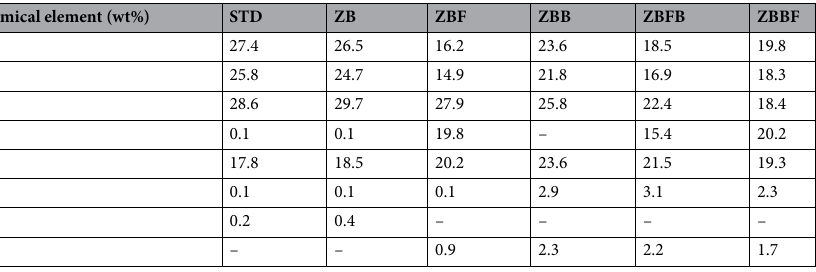
Table 2. The chemical elements of zeolite A standard (STD), zeolite A sugarcane bagasse fly ash powder (ZB), zeolite A sugarcane bagasse fly ash powder mixed iron(III) oxide-hydroxide (ZBF), zeolite A sugarcane bagasse fly ash beads (ZBB), zeolite A sugarcane bagasse fly ash powder mixed iron(III) oxide-hydroxide beads (ZBFB), and zeolite A sugarcane bagasse fly ash beads coated iron(III) oxide-hydroxide (ZBBF) by EDX analysis.